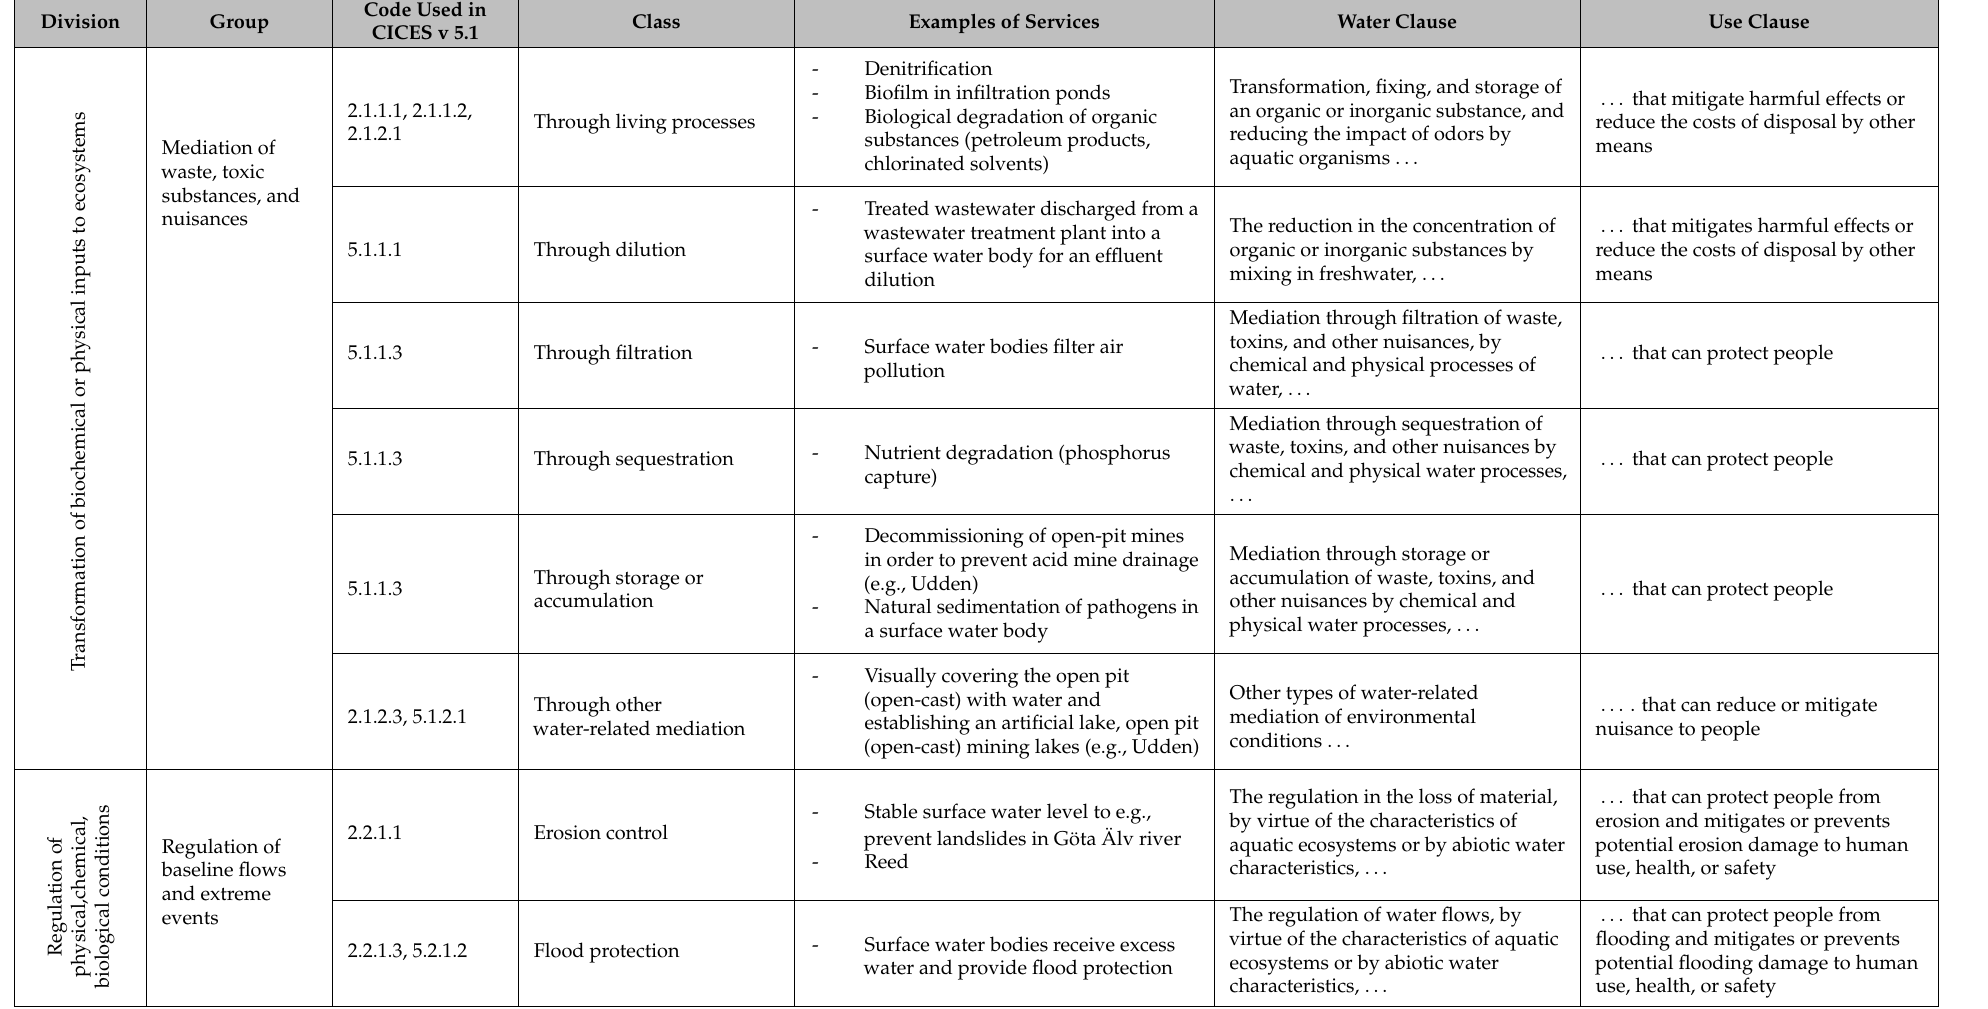
Table A2. Regulating services. The water clause and use clause define the class.